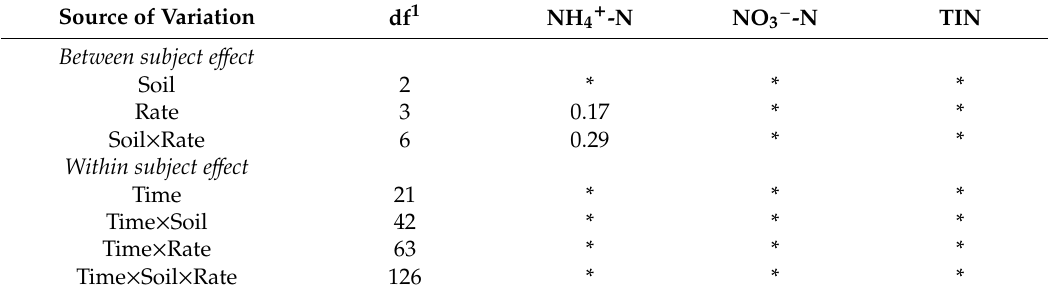
Table 2. Significance ( P value) of repeated-measures MANOVA results on soil nitrate (NO 3 −